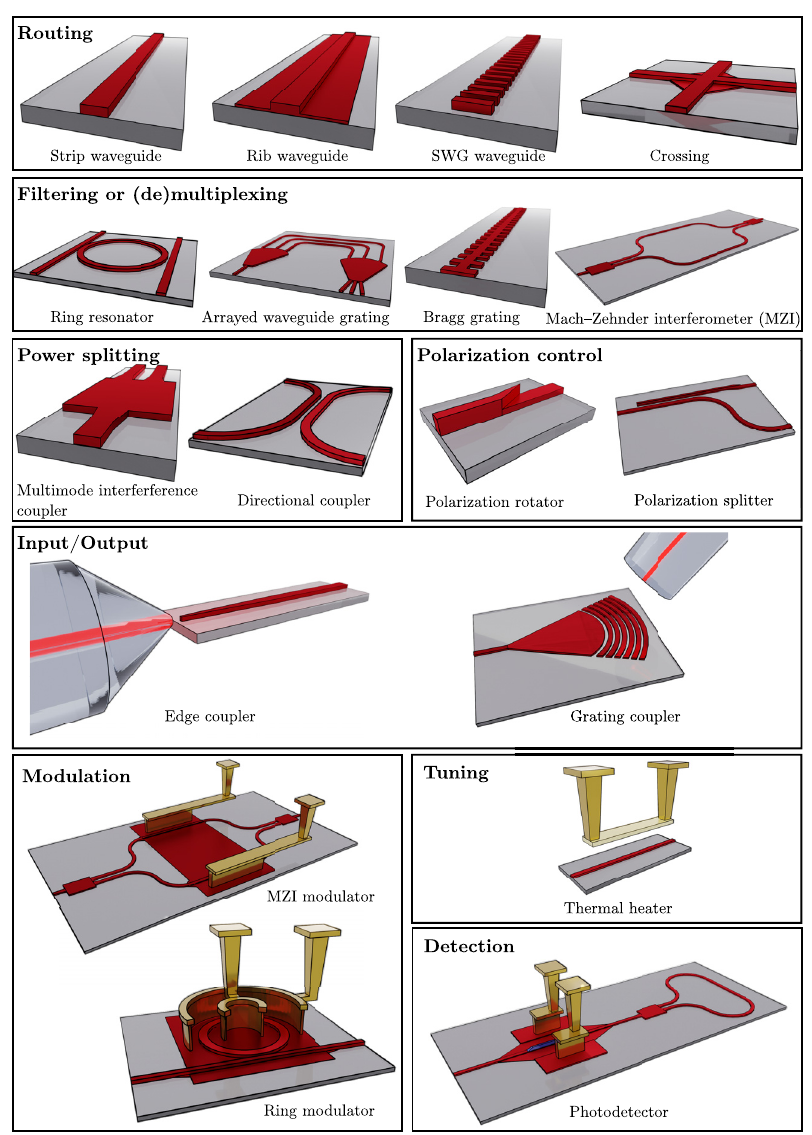
Figure 4: Mock-ups of the most common building blocks used in silicon photonics, classi fi ed by functionality. The structures are not to scale, and the top cladding layer is absent for visibility. The colors of the materials are the same as in Figure